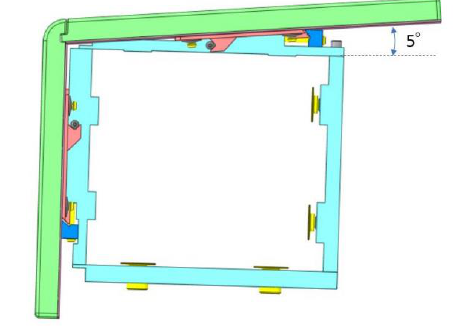
Fig. 10. Concept of an interceptor